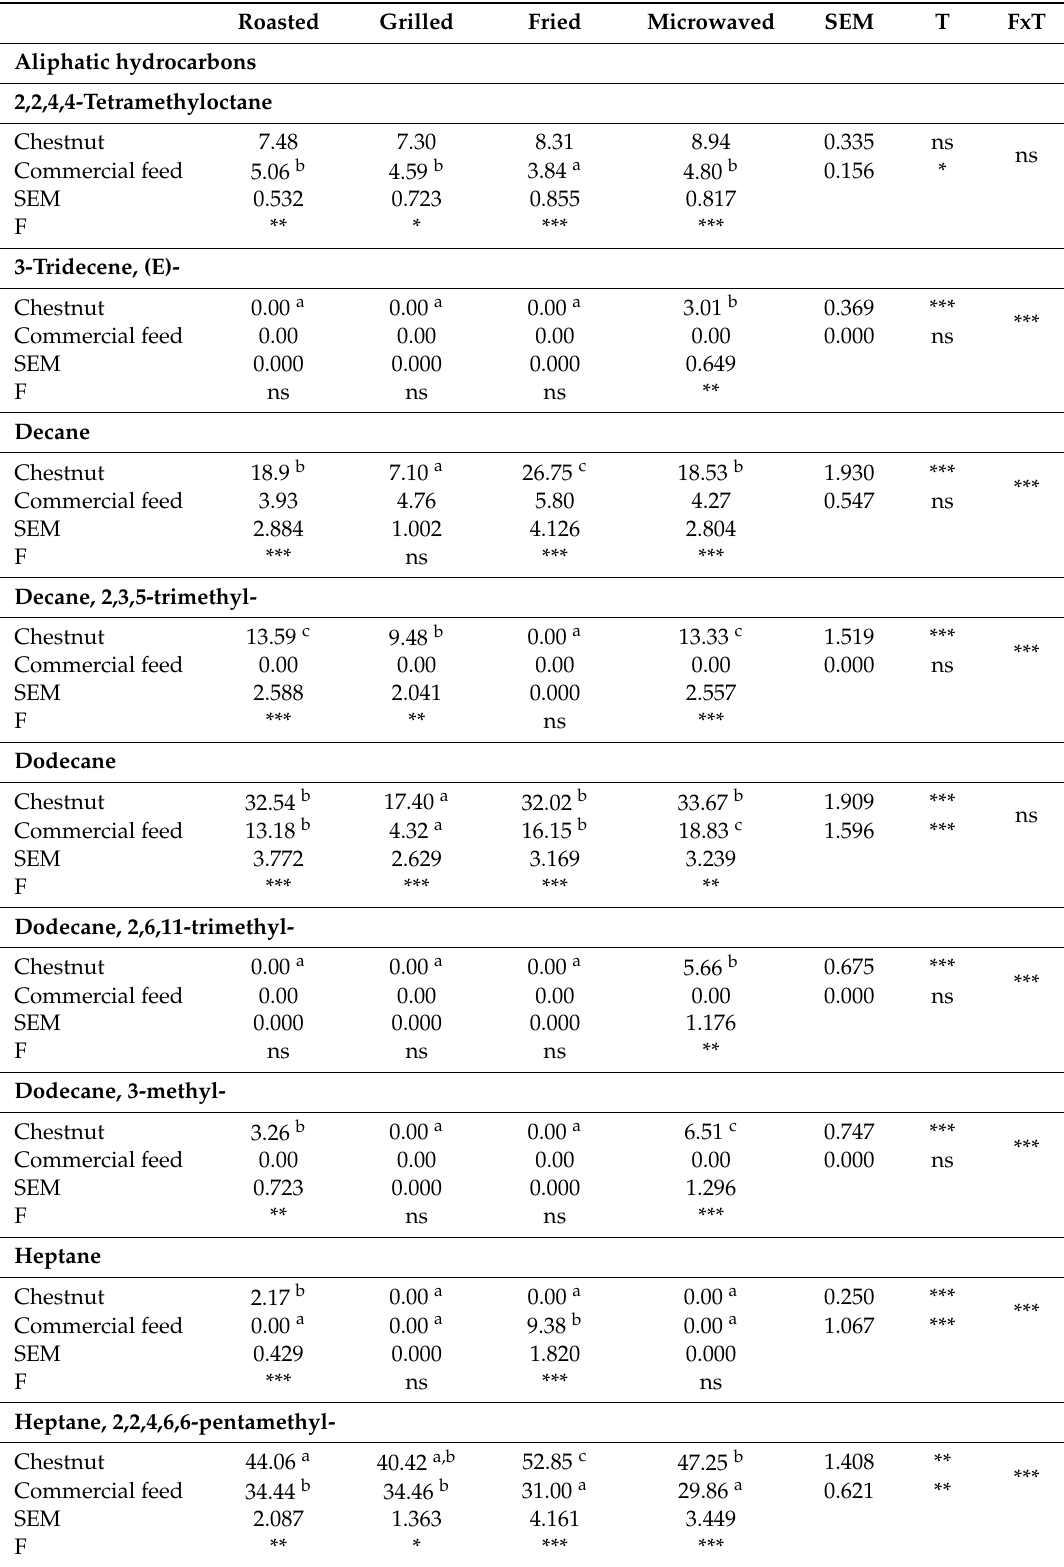
Table 4. E ff ects of the inclusion of chestnut in the finishing diet and of cooking methods on the volatile compounds (expressed as AU × 10 6 / g dry matter) of Celta pig Biceps femoris